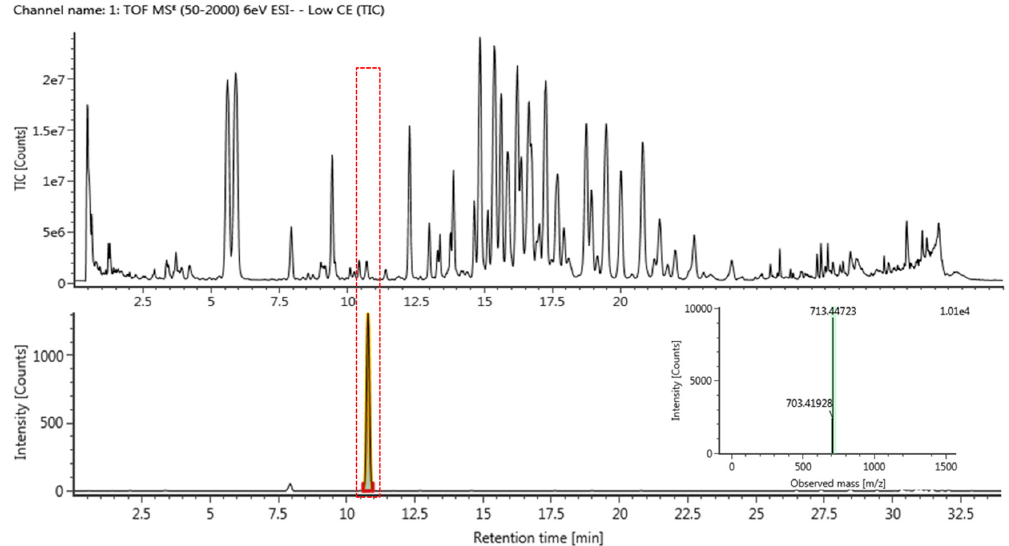
Figure 2. TIC of HPGL extract and ginsenoside Rh23 by UPLC-QTOF/MS in negative-ion mode by selected ion monitoring, and representative QTOF/MS chromatograms A linear calibration curve was obtained for ginsenoside Rh23 at different concentration levels.